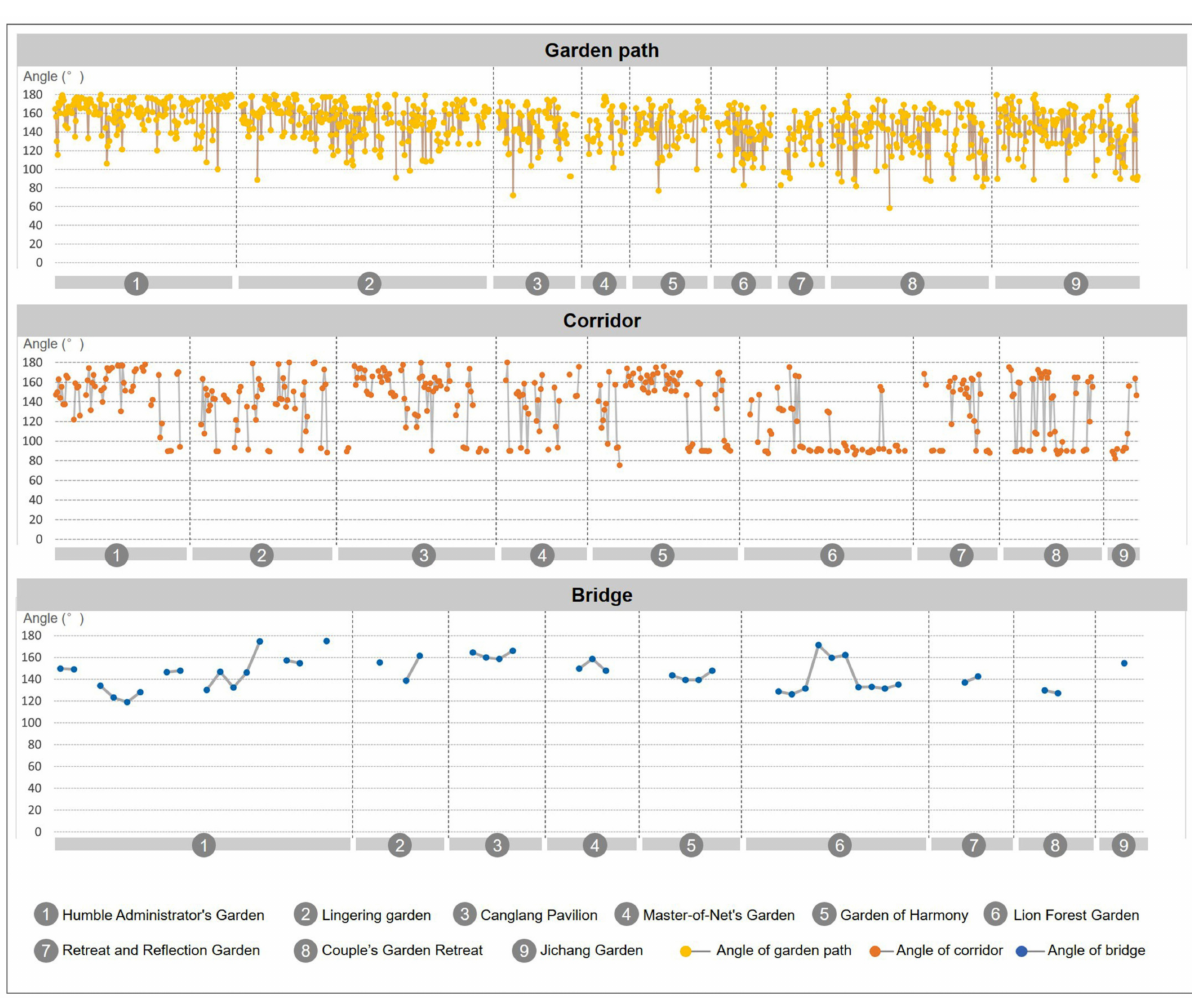
Figure 6. Nine typical garden road system angle analysis